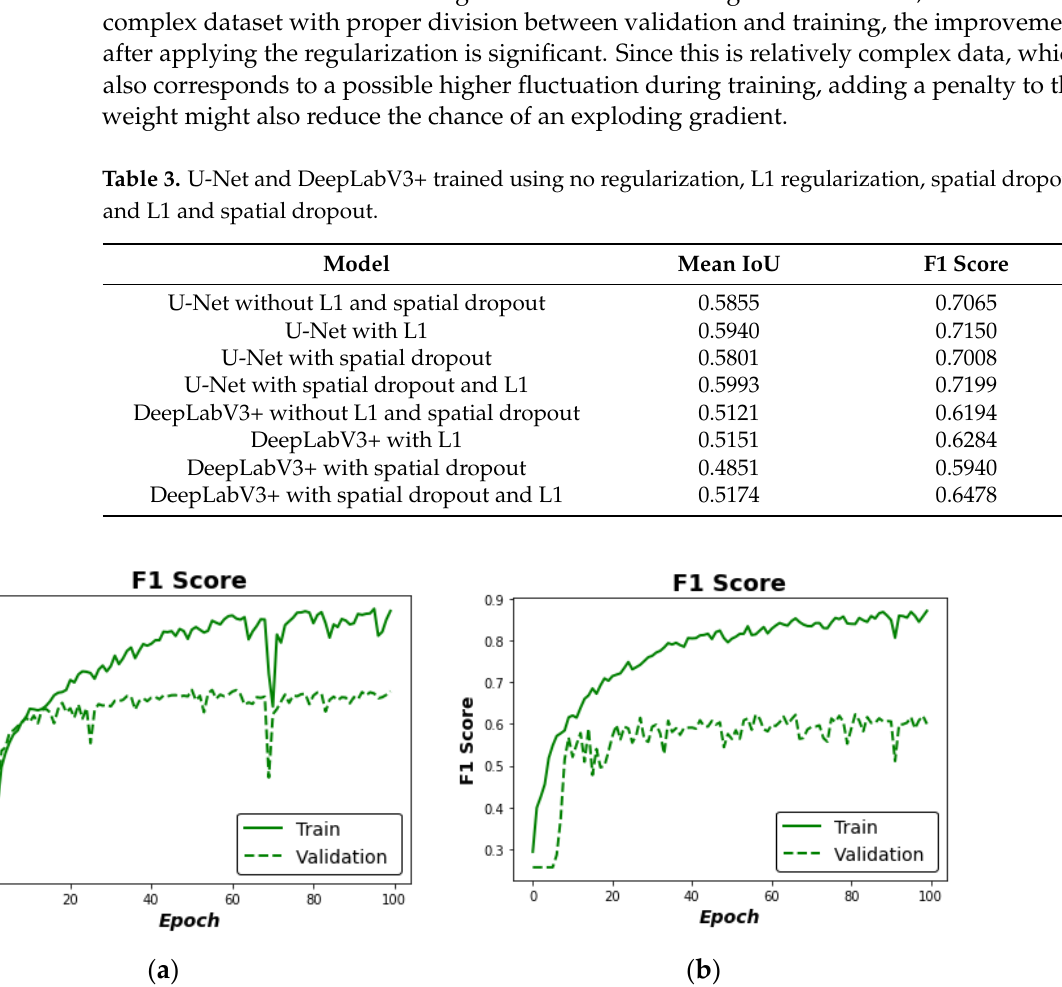
Figure 17. ( a ) U-Net without L1 and spatial dropout F1 curve; ( b ) DeepLabV3+ without L1 and spatial dropout F1 curve.